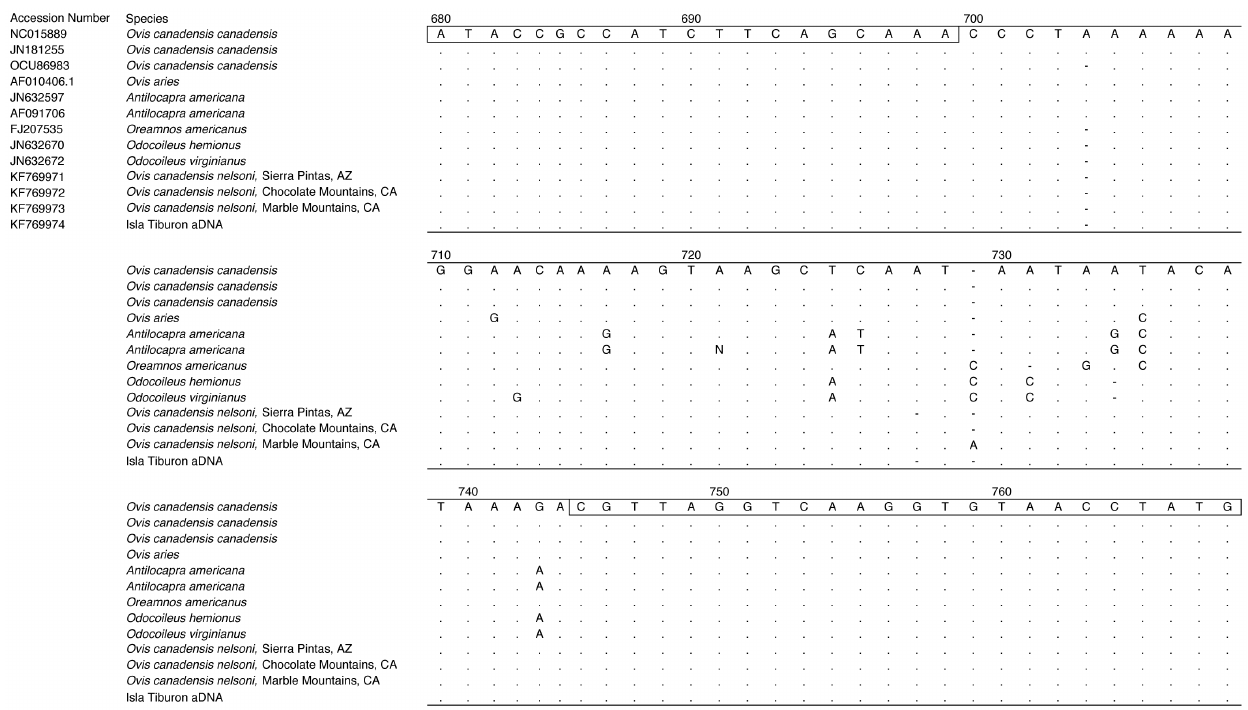
Figure 3. Isla Tiburo´n a DNA and Sonoran Desert ungulate sequences. Partial sequences of the 12S ribosomal RNA subunit of the mitochondrial genome for the Isla Tiburo´n a DNA sample and published sequences from all ungulate species thought to have existed in the area since the start of the Holocene, with GenBank accession numbers. Open box denotes primer region, dot indicates identical bases between sequences, N indicates unknown base. Sequence position numbers are derived from O. c. canadensis haplotype (GenBank Accession NC015889).